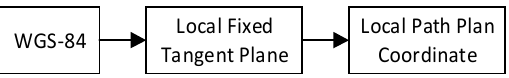
Figure 8. The converting sequence of several coordinate systems.